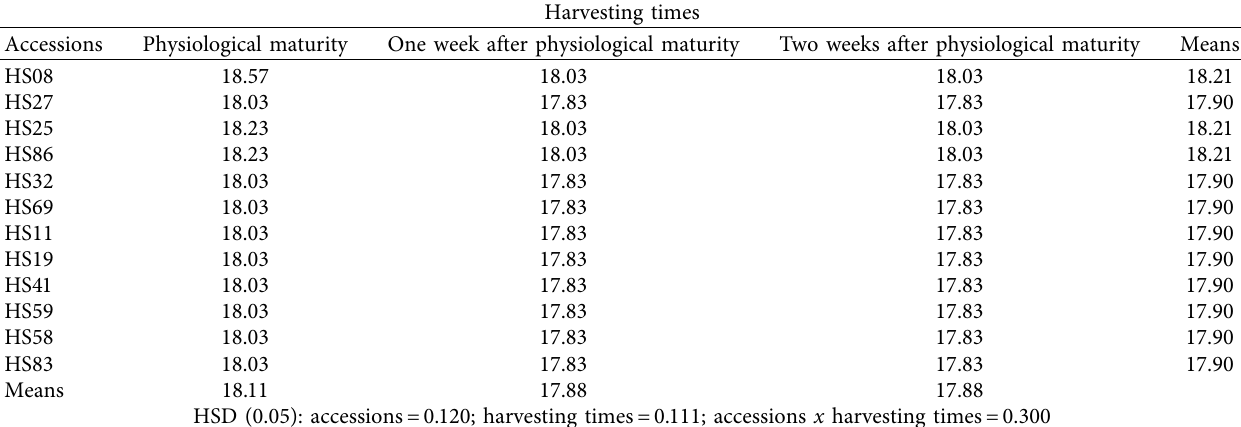
Table 9: Surface area (mm2) of roselle seeds accessions as influenced by harvesting times and accessions. Harvesting